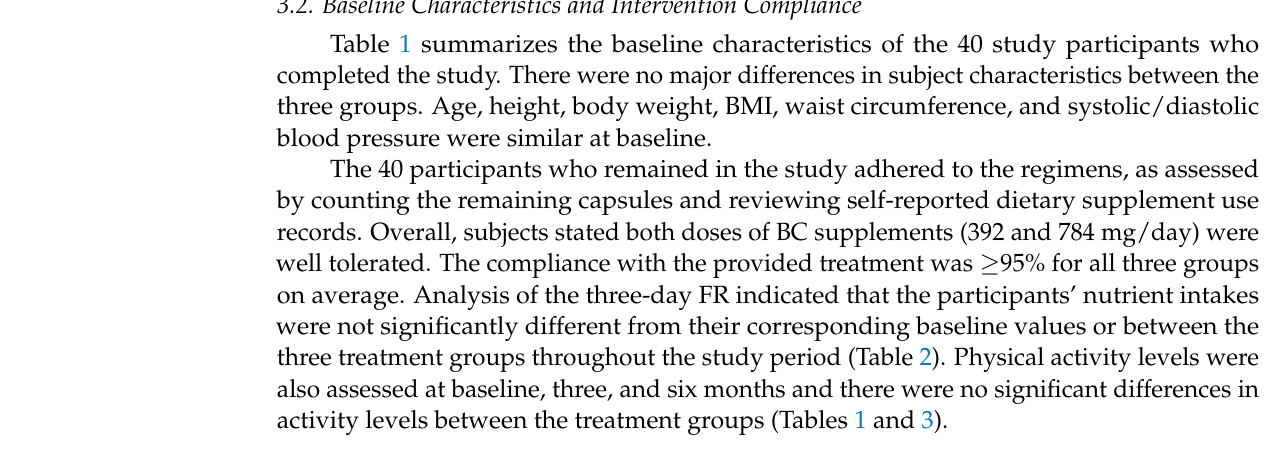
Table 2. Daily average nutrient intake of study participants calculated from three-day food records at baseline, three months, and six